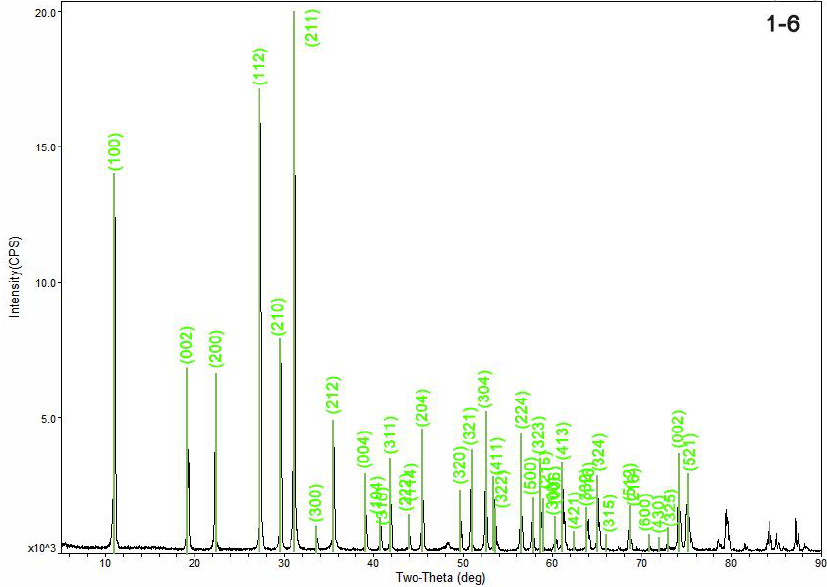
Figure 6. XRD pattern of no.1–6. Beryl peaks were marked by green lines. Beryl’s symmetry is P6/mcc (D 6h2 ). The crystal cell parameters can be obtained by XRD and refinement. In standard beryl samples (PDF card: 09-4310), a 0 = 9.217 Å and c 0 = 9.192 Å. When the octahedral Al 3+ is replaced by transition metal ions, a 0 increases due to the increase of the ion radius, whereas when the tetrahedral Be 2+ is replaced by Li + or Cu 2+ , c 0 increases. Beryl can be divided into two types according to the c/a value [26]: Octahedral substitution of Al 3+ is dominant: c/a = 0.991–0.998; Tetrahedral substitution of Be 2+ is dominant: c/a = 0.999–1.003. XRD was carried out on the samples, and JADE 6.5 was used to refine the diffraction lines. With reference to the standard beryl PDF card 09-4310, the crystal cell parameters were obtained (Table 2). Both tetrahedral and octahedral substitutions can be found because the a 0 and c 0 of the samples were higher than the standard beryl, and the octahedral substitutions were the main